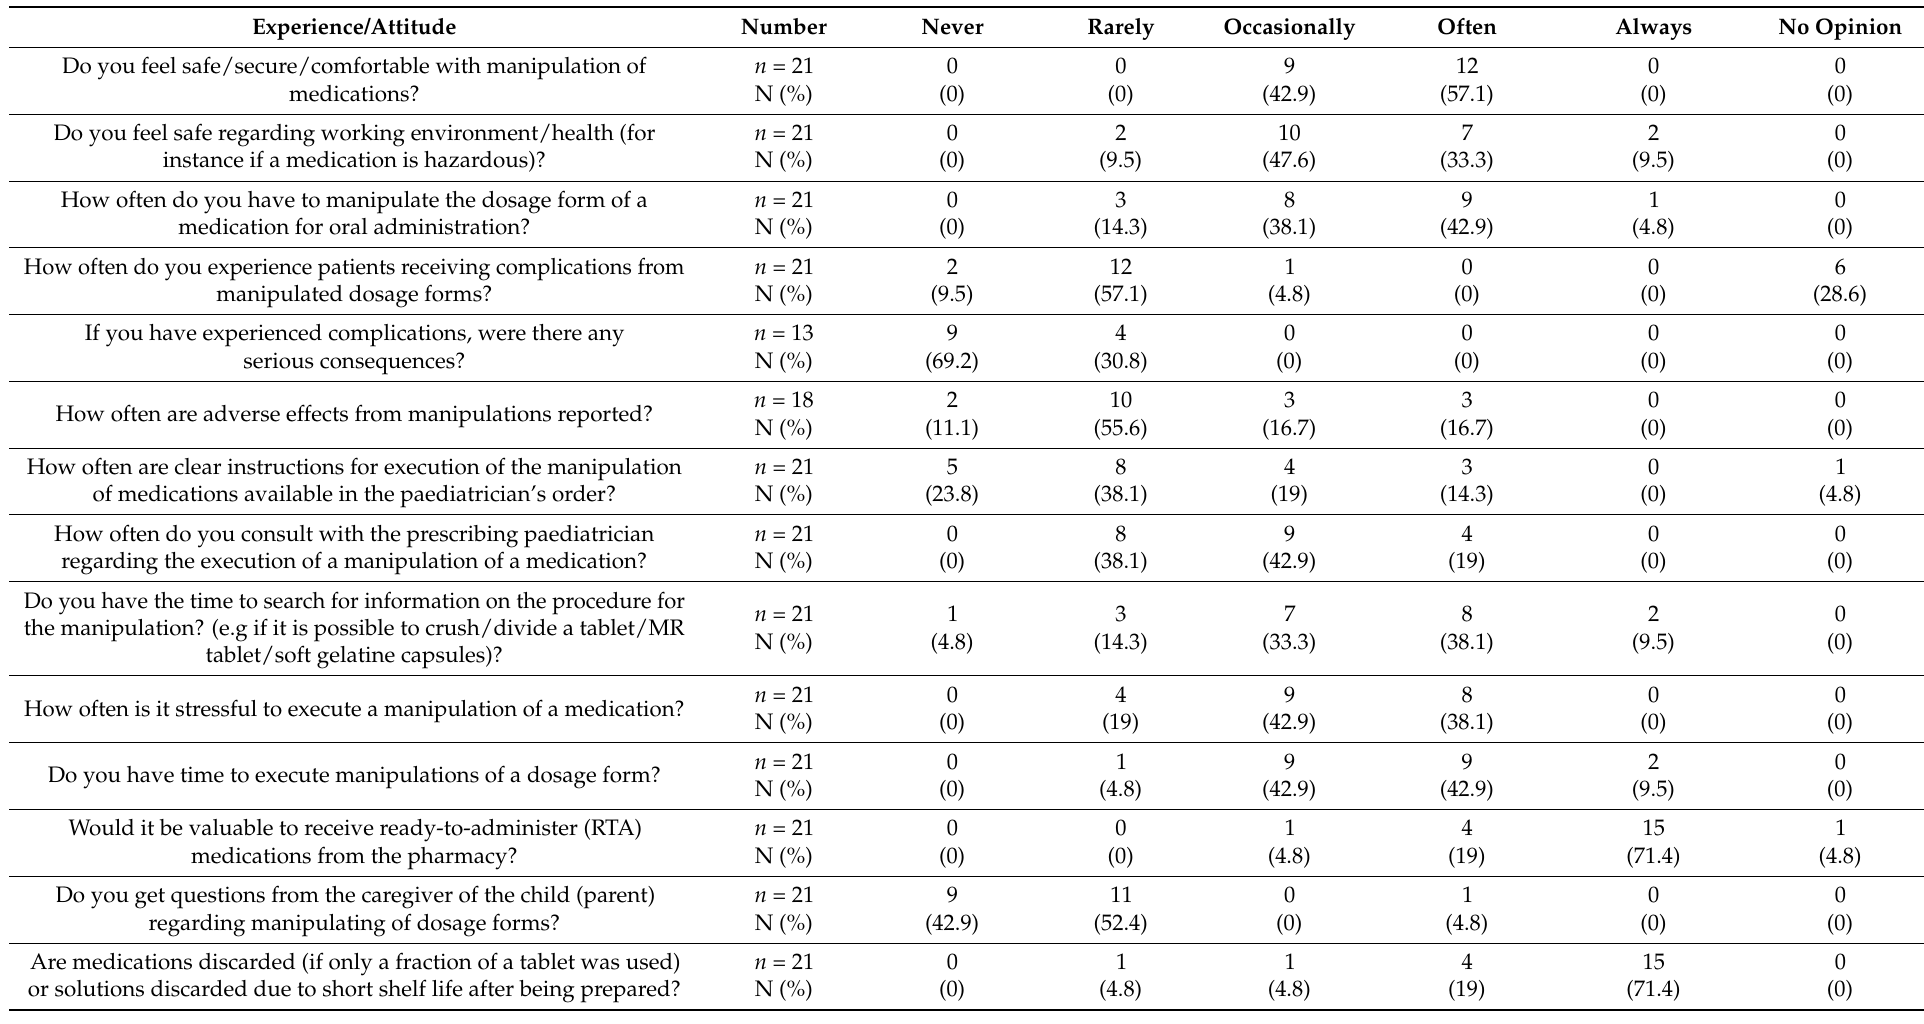
Table 5. Respondent paediatric oncology and neurology nurses’ experiences and attitudes. MR = modified release